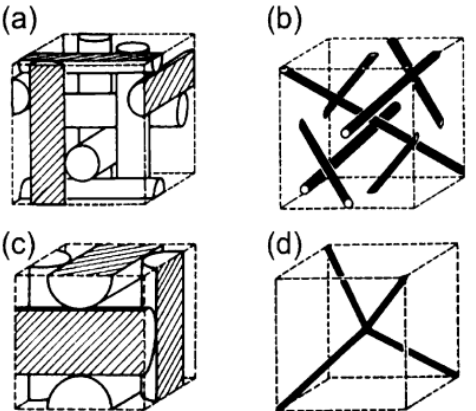
Figure 2. Structures of Blue Phases I and II. The rods in ( a , c ) represent the double-twist cylinder. The black lines in ( b , d ) represent disclination lines [59] . Liquid Crystalline Blue Phases from Kikuchi, Liquid Crystalline Functional Assemblies and Their Supramolecular Structures; published by Springer Nature.